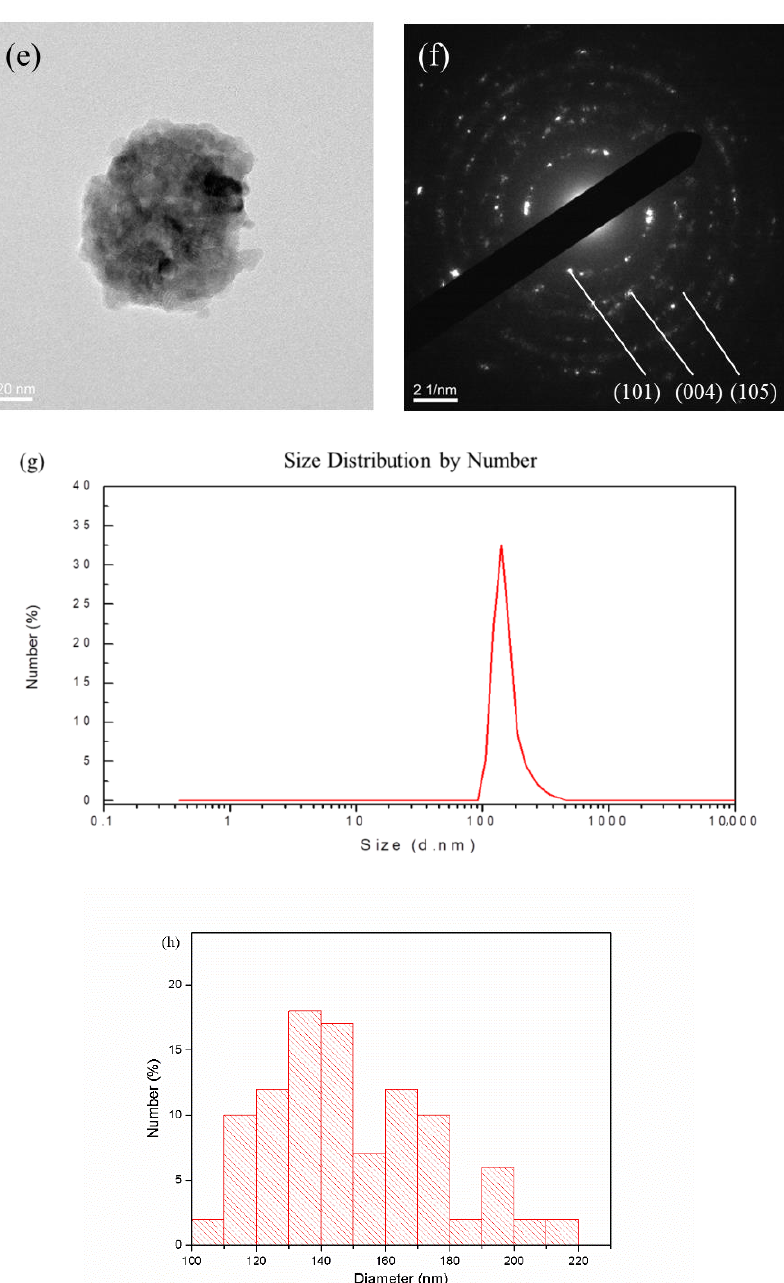
Figure 2. ( a ) XRD pattern of C-doped TiO 2 , ( b ) low-magnification SEM images of C-doped TiO 2 , ( c ) high-magnification SEM images of C-doped TiO 2 , ( d ) EDS of C-doped TiO 2 , ( e ) TEM images of C-doped TiO 2 , ( f ) Diffraction pattern of C-doped TiO 2 , ( g ) Size distribution of C-doped TiO 2 and ( h ) SEM particle size distribution of C-doped TiO 2 .